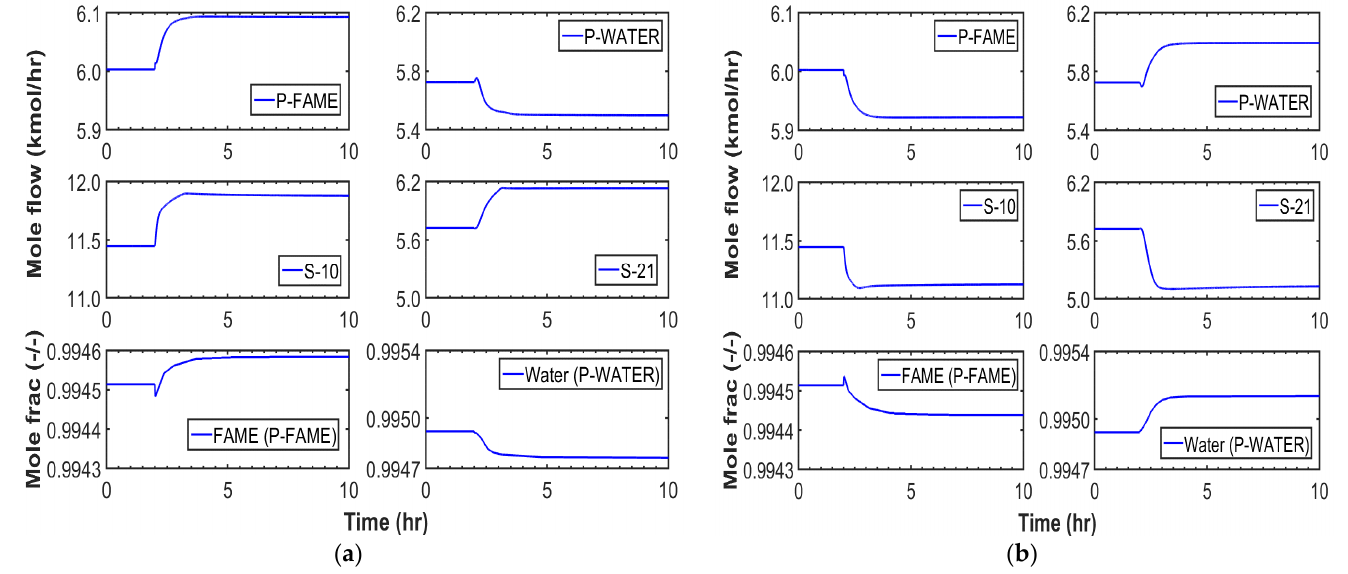
Figure 9. Stream results when the methanol feed flow was changed; ( a ) +5% change; ( b ) − 5% change.